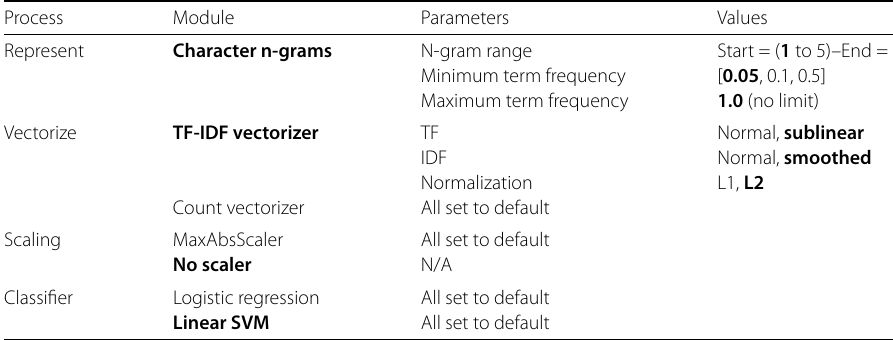
Table 6 Parametrization of word n-grams models. Optimal settings are typeset in bold Process Module Parameters Values